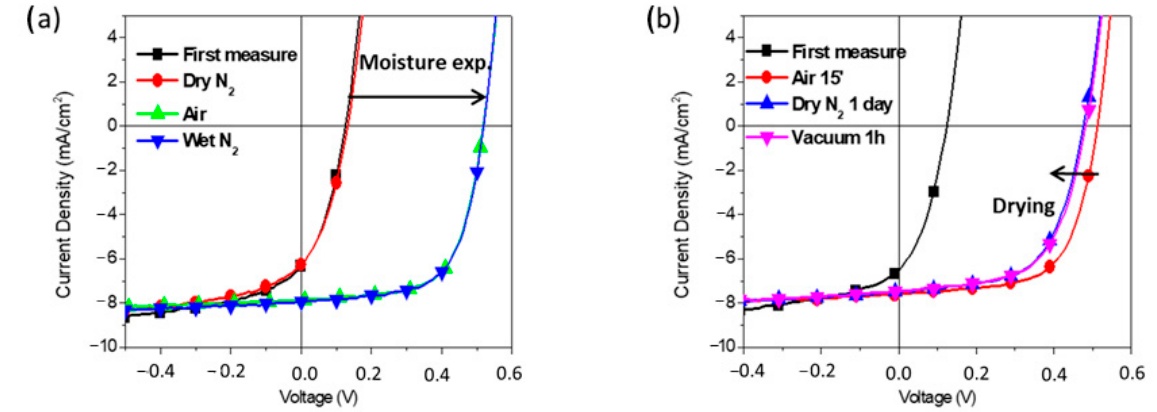
Figure 7. J–V curves of inverted devices stored for 15 min in different atmosphere conditions; ( a ) moisture exposure in air or in N 2 atmosphere with a similar moisture content to air (50 % RH): Air and wet N 2 ; first measure and dry N 2 correspond respectively to a first and a second curve recorded after 15 min, for a device kept inside the glove box. ( b ) Drying of a device exposed to air for 15 min upon storage in a glovebox overnight prior and after 1 h under vacuum (10–7 atm.): Air 15 min, dry N 2 overnight, 1 h vacuum; first measure is the J–V curve prior to air exposure.